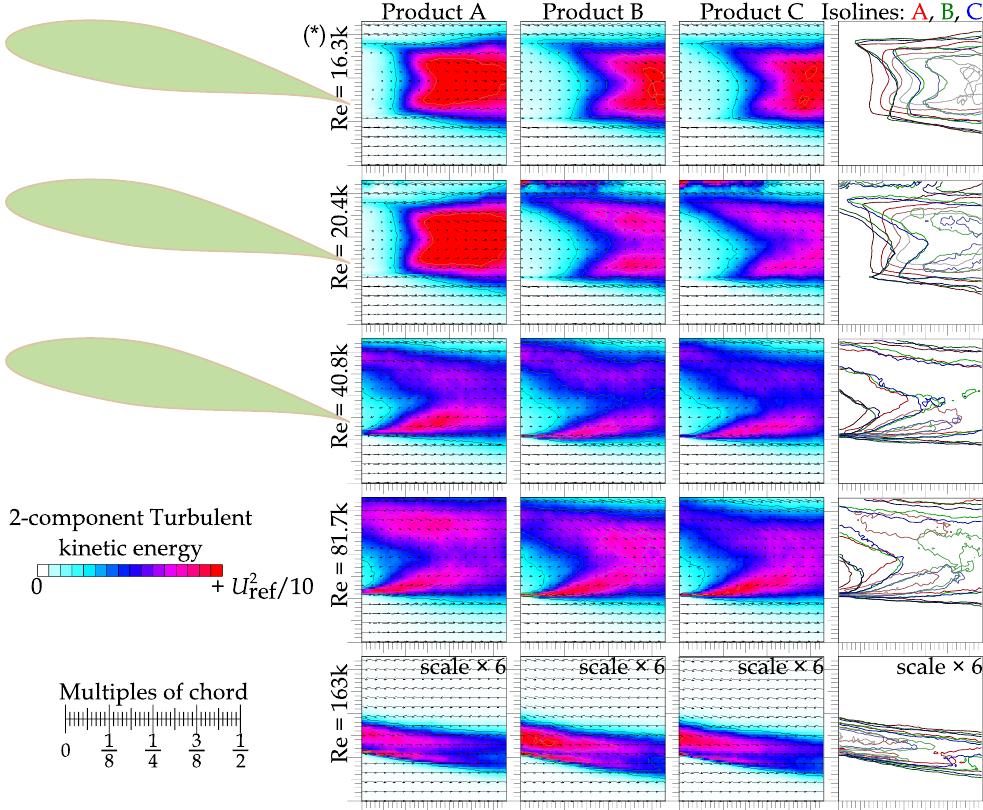
Figure A3. Map of turbulent kinetic energy at angle of attack α = 10 ◦ . The first row is added; it is denoted (*) and contains data at Re = 1.63 × 10 4 in order to show that the wake past product A at Re = 2.04 × 10 4 belongs to the previous